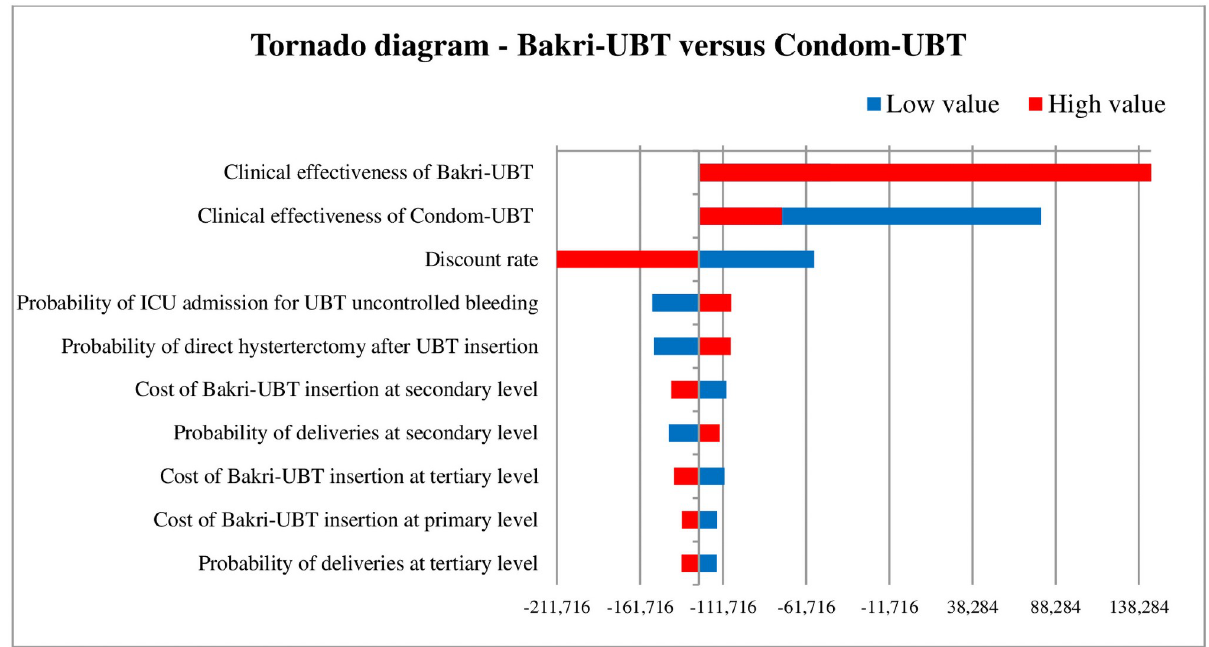
Fig 3. Tornado diagram showing one-way sensitivity analysis results for Bakri-UBT versus condom-UBT comparison. As clinical effectiveness of Bakri-UBT increases, Bakri-UBT is still not cost-effective (Bakri-UBT is more expensive, more effective) at the willingness to pay threshold of INR 24,211. As effectiveness of Bakri-UBT decreases (masked), Bakri-UBT is not cost-effective (Bakri-UBT is more expensive, less effective) as compared to condom-UBT. Similarly, for condom-UBT clinical effectiveness parameter, as condom-UBT effectiveness increases, Bakri-UBT is not cost-effective (Bakri-UBT is more expensive, less effective) as compared to condom-UBT. As condom-UBT effectiveness decreases, Bakri-UBT is still not cost- effective (Bakri-UBT is more expensive, more effective) at the given WTP threshold.